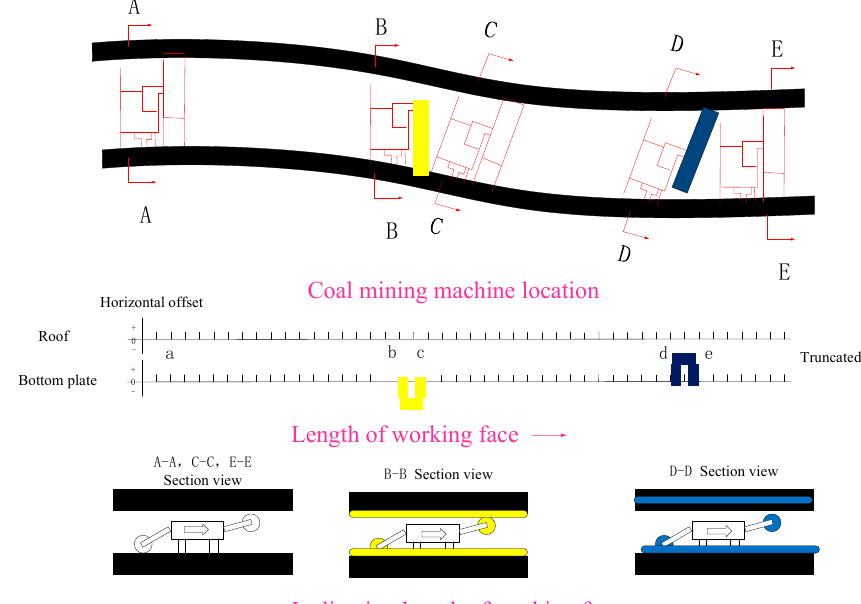
Figure 2. Schematic diagram of shearer memory cutting technology: A-A, C-C and E-E means that the shearer drum is normally cutting coal, B-B means that the position of the shearer drum is lower, D-D means that the position of the shearer drum is on the upper side.